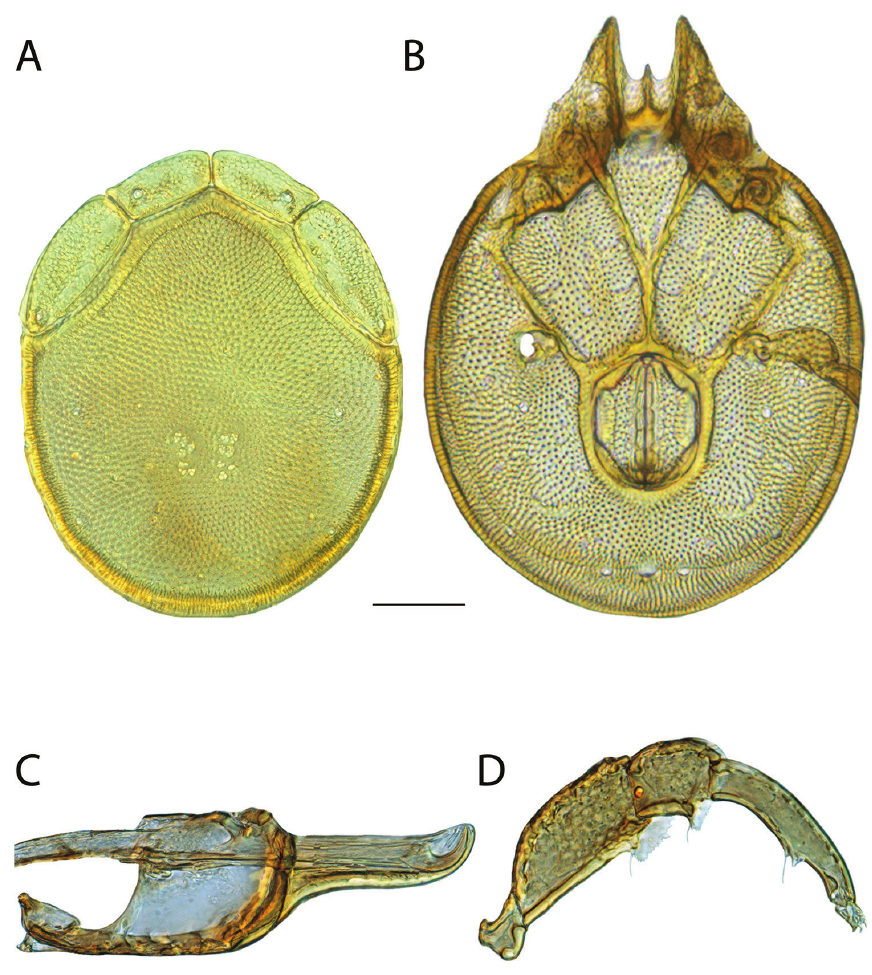
Figure 113. Torrenticola keesdavidsi male: A dorsal plates B venter (legs removed) C subcapitulum D pedipalp (setae not accurately depicted). Scale = 100